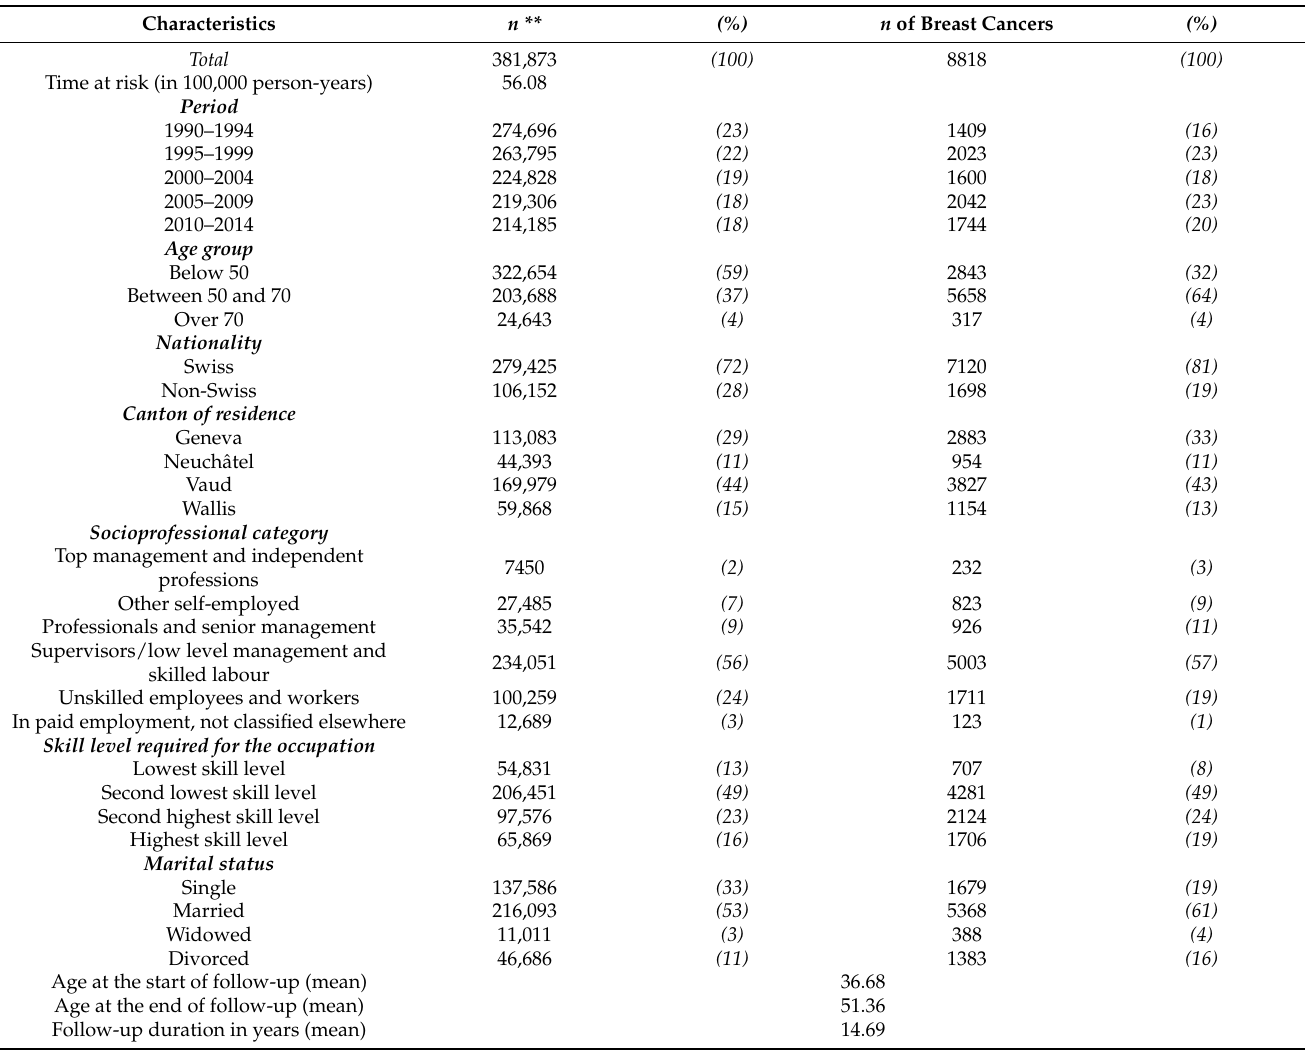
Table 1. Characteristics of the study population and number of malignant breast cancer cases in western Switzerland, 1990–2014